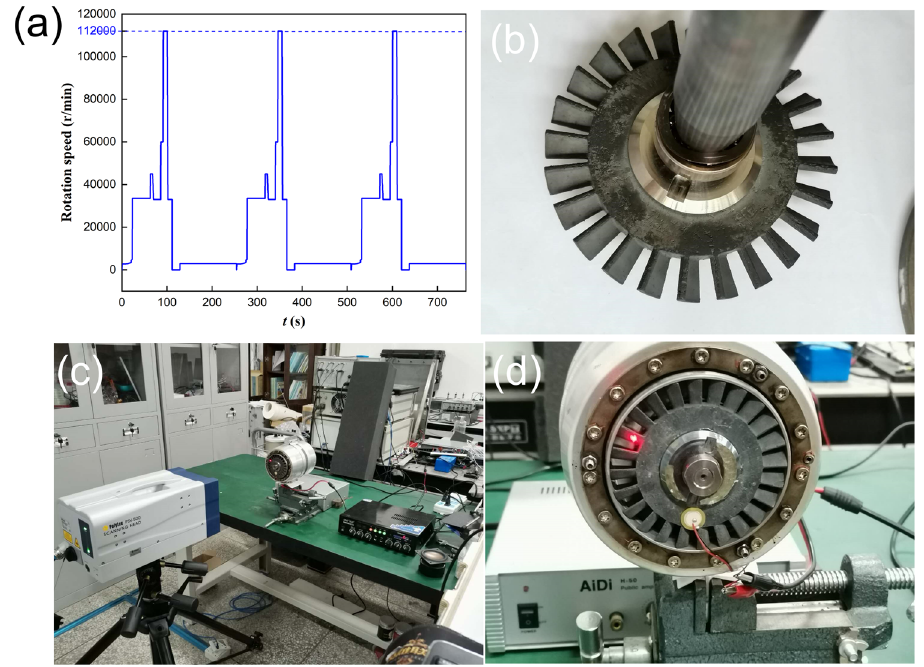
Figure 4: ( a ) Schematic of test load spectrum; ( b ) assembly of SWS - SiC/SiC turbine blisk and shaft; ( c ) laser vibration meter; and ( d ) natural frequency